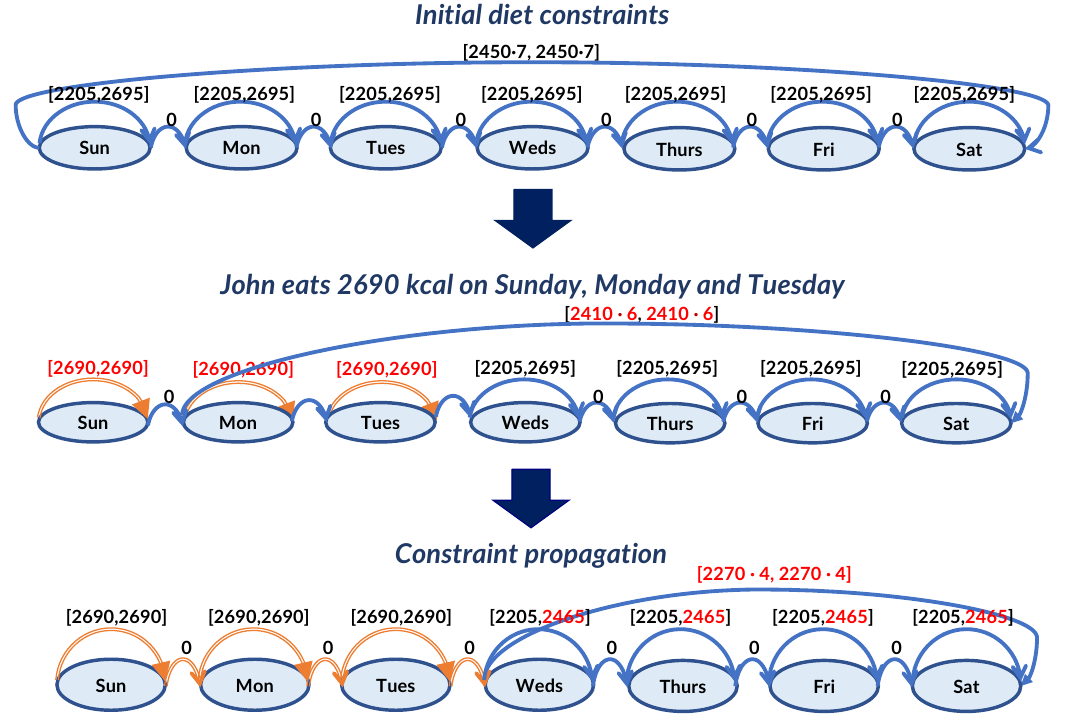
Figure 2. Graphical representation of the simple temporal problem (STP) constraints modelling a diet. For the sake of simplicity, in the figure, we do not represent the macronutrients, nor the single meals, but only the total energy in a day. In the top part, we represent the STP corresponding to the dietary constraints at the beginning of a week. In the middle part, we have the STP after the first three days, where John ate 2690 kcal on each day; notice that also imprecision in the measurement is supported [12]. In the bottom part, we represent the STP resulting from the constraint propagation where—as a result of food eaten in the first three days—John has to eat between 2205 kcal and 2465 kcal each day for the rest of the week and a total in the remaining four days of 2270 · 4